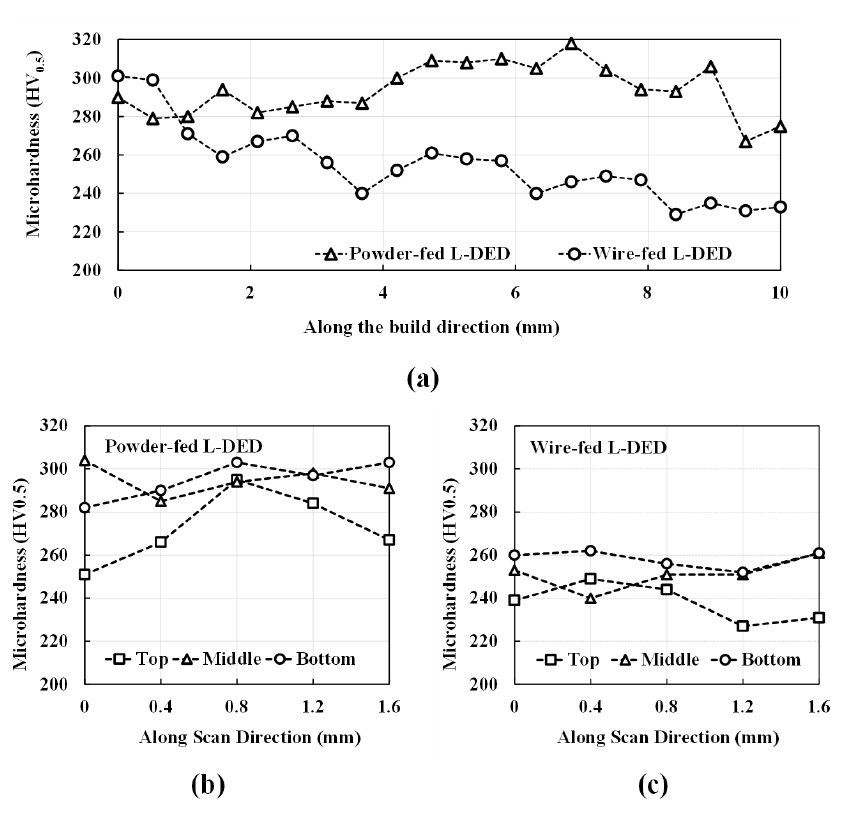
Figure 16. A comparison of the microhardness measurements of powder- and wire-fed specimens: ( a ) along the build direction and along the scan direction at the top, middle, and bottom sections of the ( b ) powder-fed L-DED specimen and ( c ) wire-fed L-DED